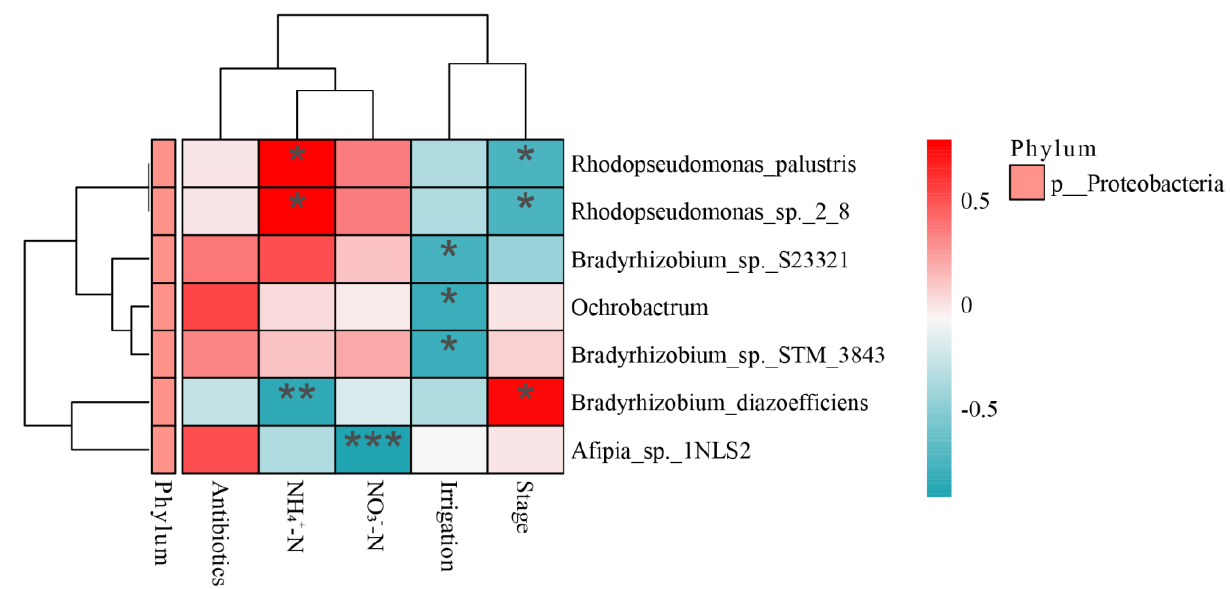
( d ) Heat map of the correlation between nirK bacteria and environmental factors at the species level Figure 5. Heat map of the correlation between nitrogen conversion flora and environmental factors. *, **, and *** indicate that the significance levels of the correlation coefficients are p < 0.05, p < 0.01, and p < 0.001, respectively. Antibiotics, the concentration gradient of the antibiotic sulfamethazine. Irrigation, irrigation methods. NH 4+ -N, the concentration of NH 4+ . NO 3 – -N, the concentration of NO 3 – . Stage, growth stages of rice.